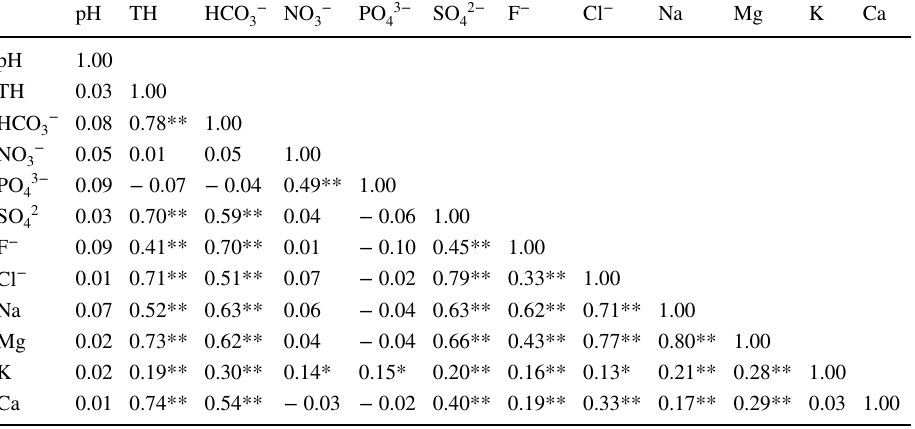
**Correlation is significant at the 0.01 level (2-tailed) *Correlation is significant at the 0.05